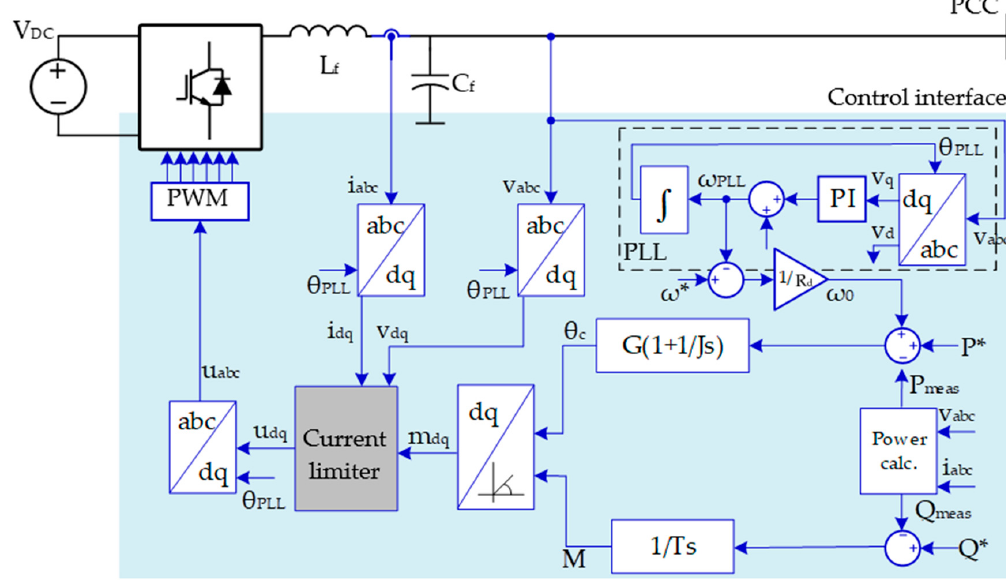
Figure 17. Grid-forming direct power control topology from [59].